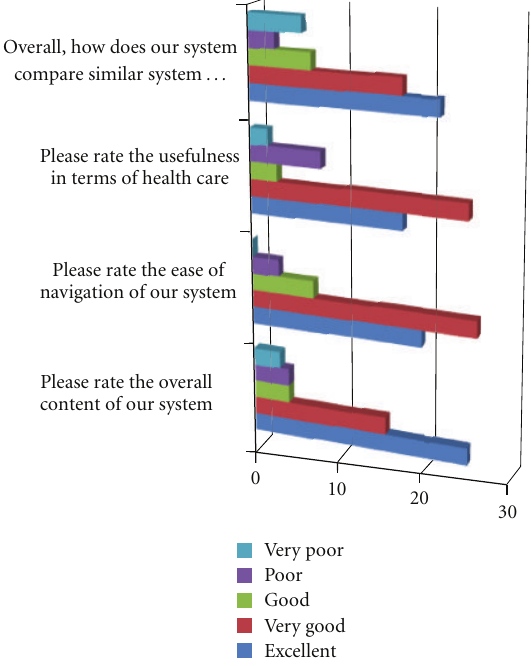
Figure 4: Ratings of the system, based on Table